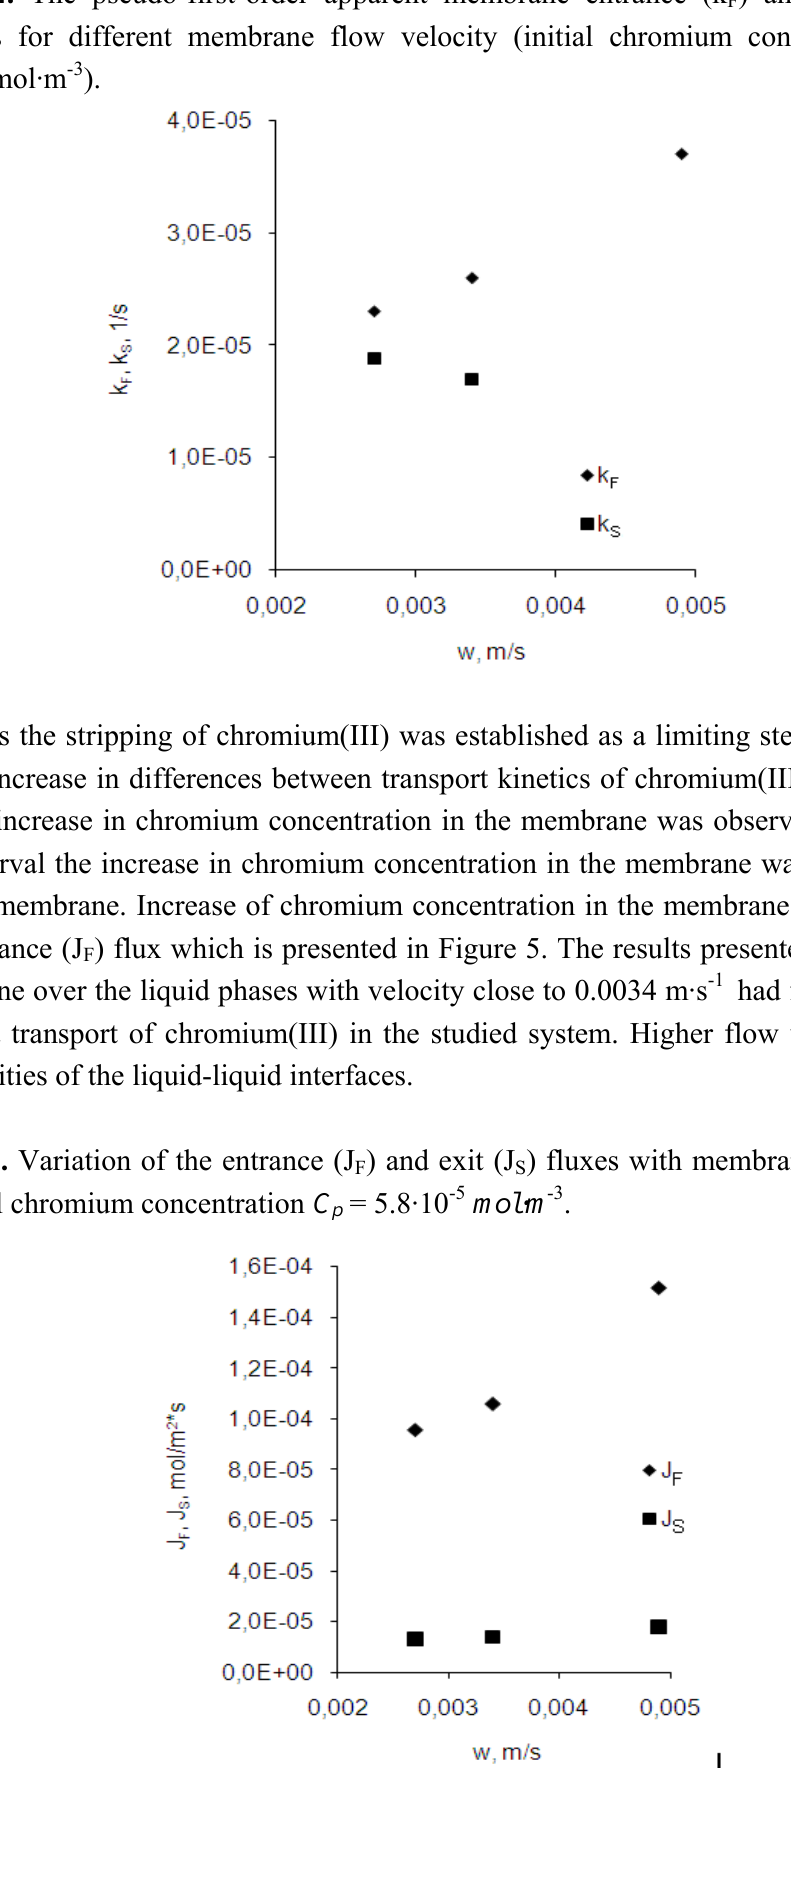
) and exit (k ) rate F S = p